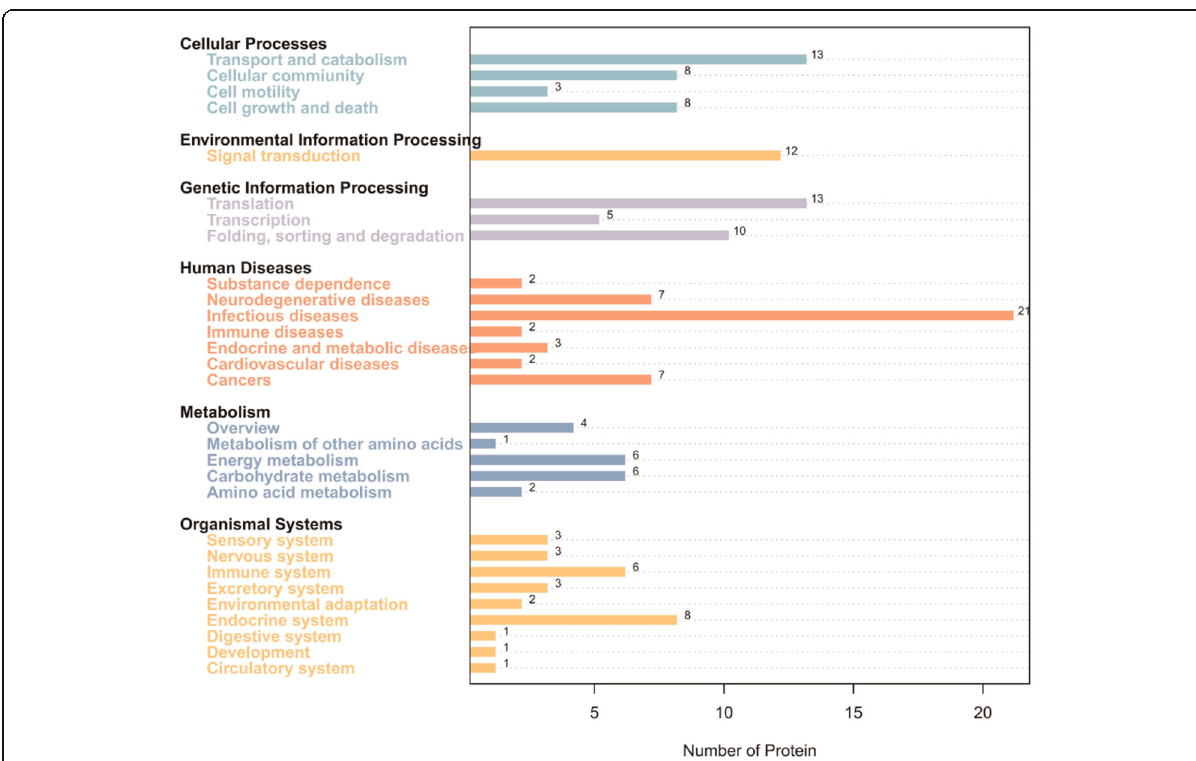
Fig. 8 KEGG pathway analysis of proteins identified in Fraction